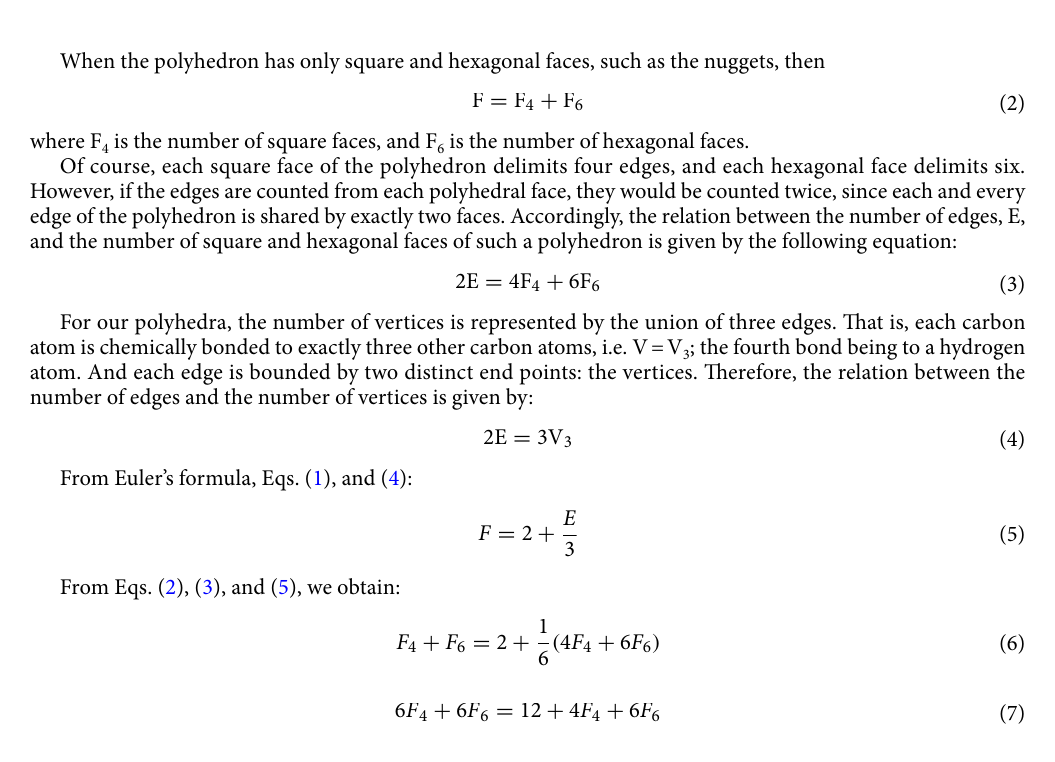
Figure 2. DFT ωB97XD/6-31G* optimized geometries of cyclobutadiene, C 4 H 4 , benzene, C 6 H 6 , cyclooctatetraene, C 8 H 8 , and cyclodecapentaene, C 10 H 10